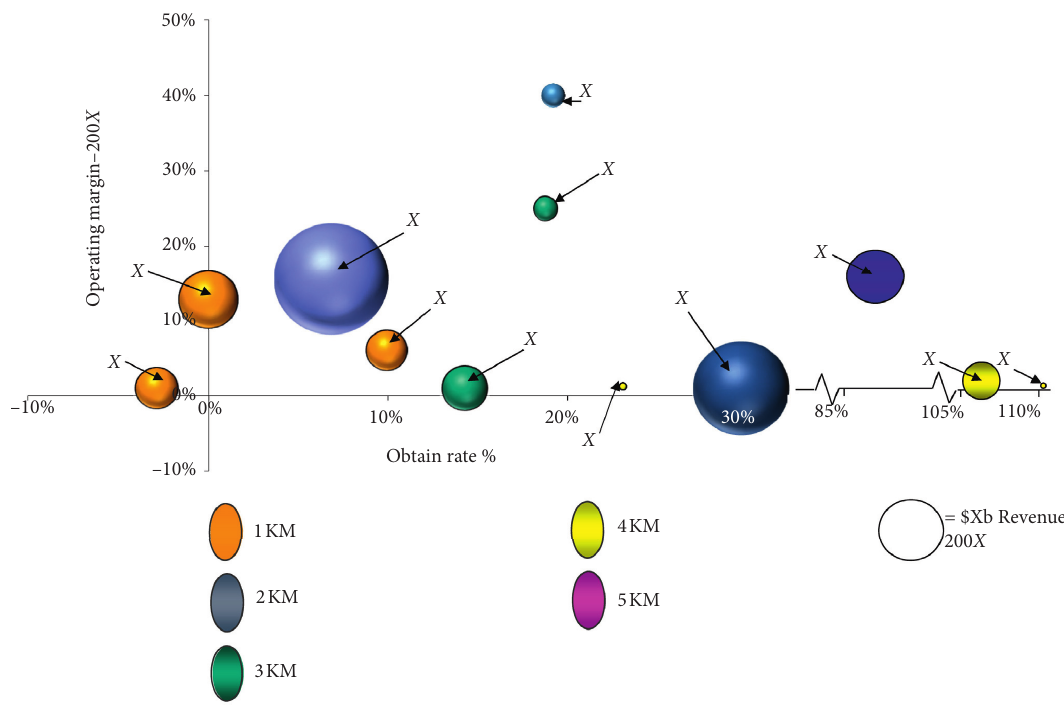
Figure 7: The test obtain rate of the actual test platform model. The interval is shown on the